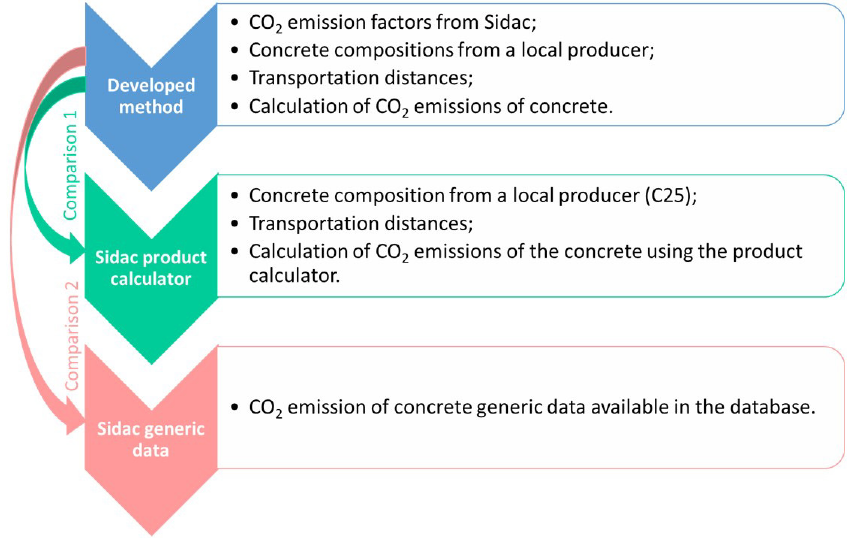
Figure 2. Flowchart of the methodology adopted in this